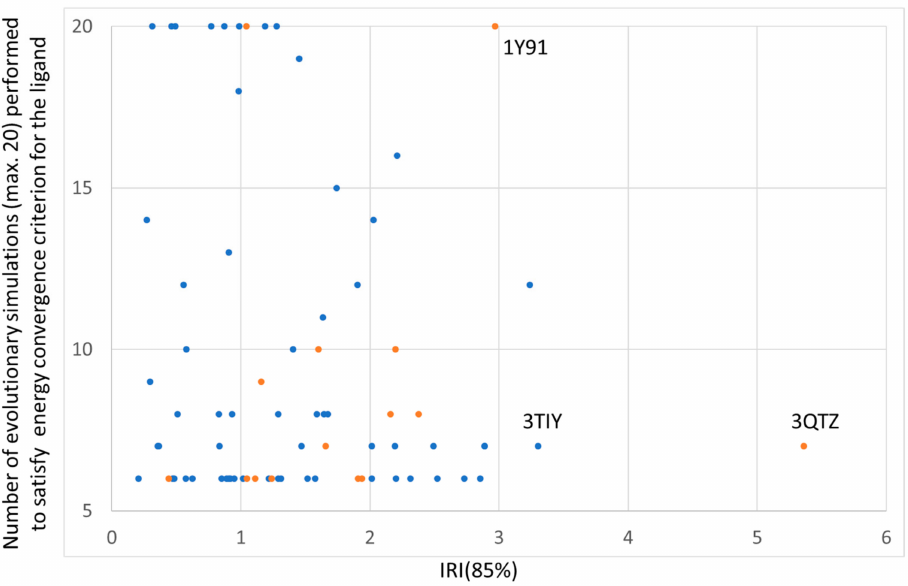
Figure 6. Simulation repeats required to reproducibly achieve best energy level, versus IRI index. On Y, the number of evolutionary simulations (limited to 20) performed by the S4MPLE docking script for each ligand in its attempt to reproduce at least five times a docking energy level within 1 kcal / mol from the known absolute optimum represents the facility to achieve convergence in terms of energy values. On X, the Irreproducibility index as estimated from the CF map measures the facility to reproduce CS coverage by distinct docking simulations. Each ligand is represented by a dot: in yellow, ligands for which the absolutely best pose in terms of energy is “native-like” (RMSD < 2 Å with respect to the PDB structure). In blue, the other ligands–for which native-like poses were sampled, but not top-ranked by S4MPLE docking